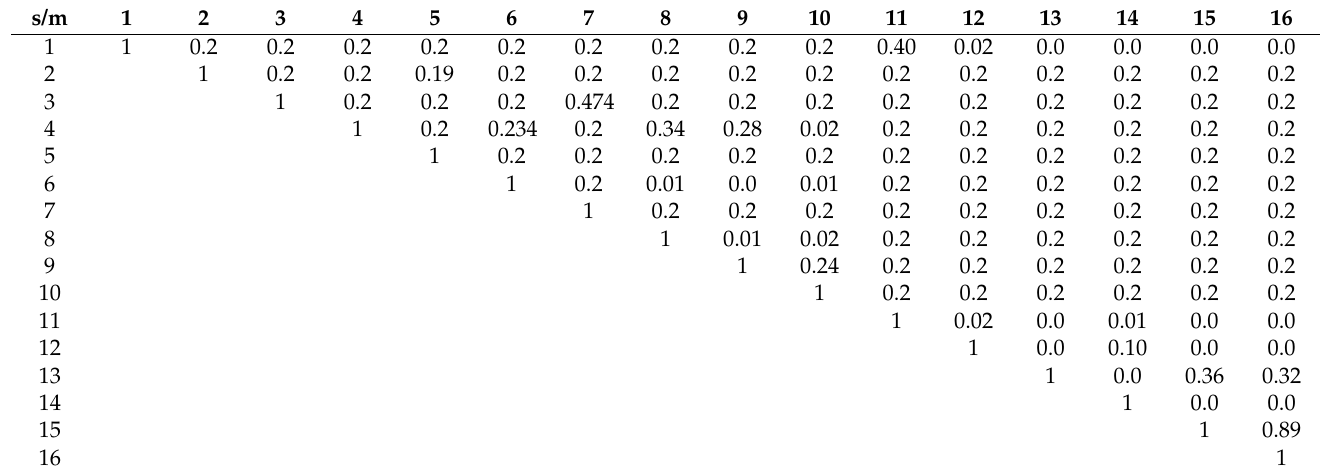
Table 5. Value of similarity index E s , m for all the pairs of nodes of Kaatiala mine map (see Figure